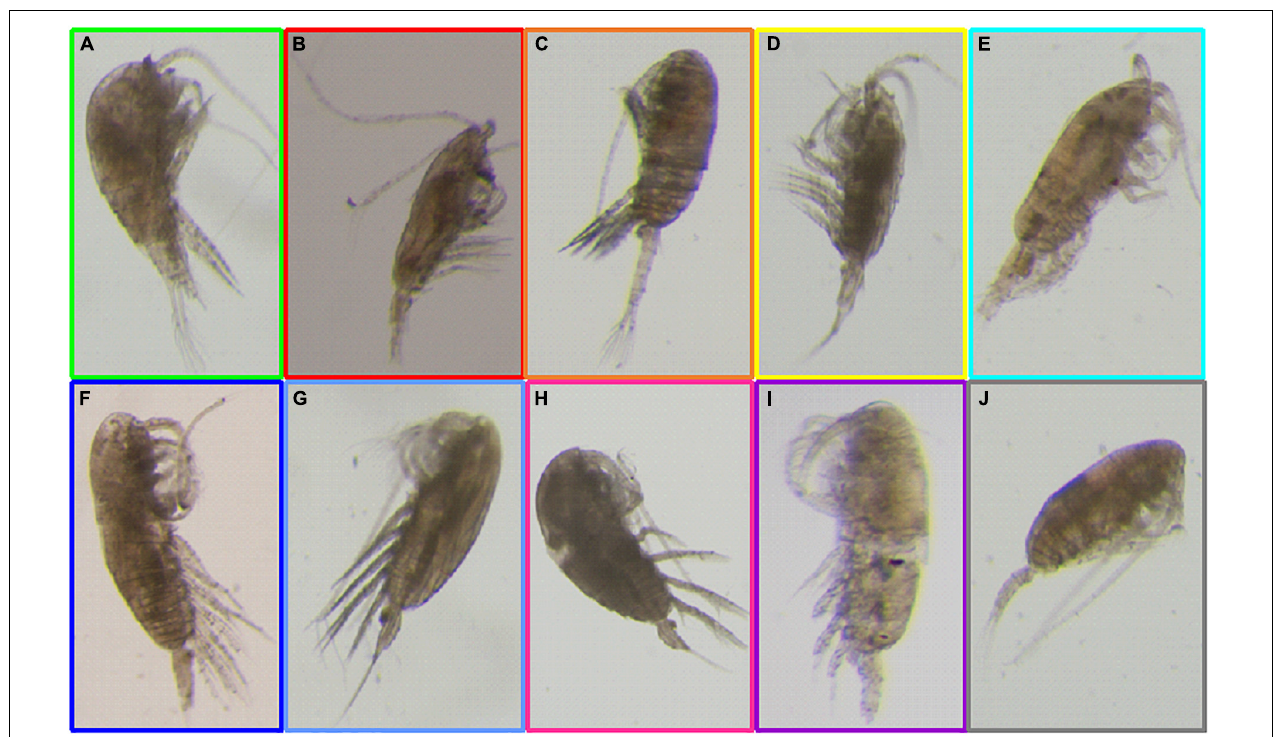
FIGURE 2 | HD-images of 10 calanoid copepod species studied in the Gulf of Naples: (A) Temora stylifera; (B) Acartia clausi; ( C) Pseudodiaptomus marinus; (D) Centropages typicus; (E) Pleuromamma gracilis; (F) Calanus helgolandicus; (G) Nannocalanus minor; (H) Euchirella rostrata; (I) Clausocalanus parapergens; (J) Ctenocalanus vanus. The total body length of the specimens showed in this Figure are reported in the Table 1